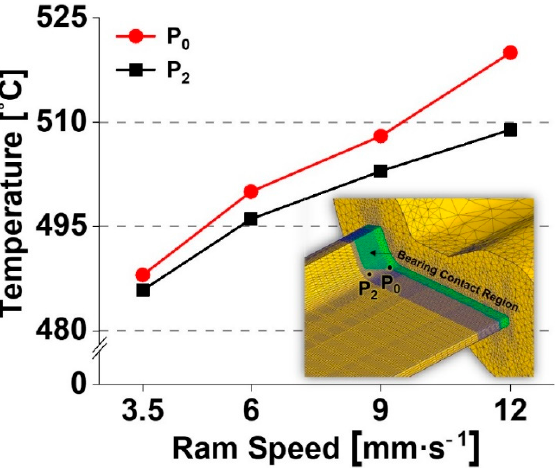
Figure 12. Temperature localization at the inner corner on the top surface of the L-shaped sample.